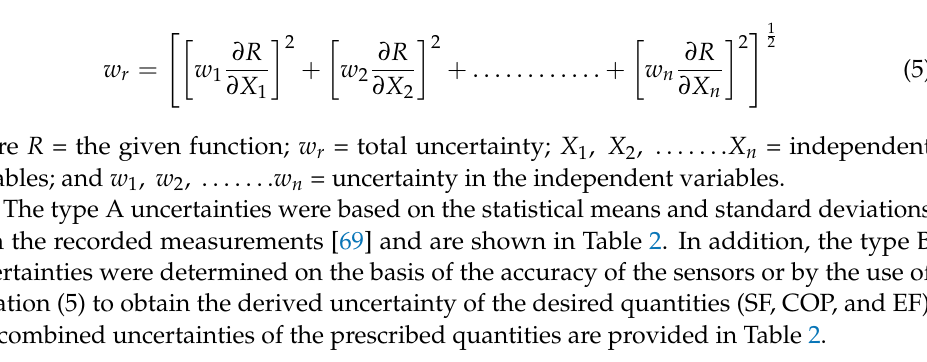
Table 2. Uncertainties of the measured and derived